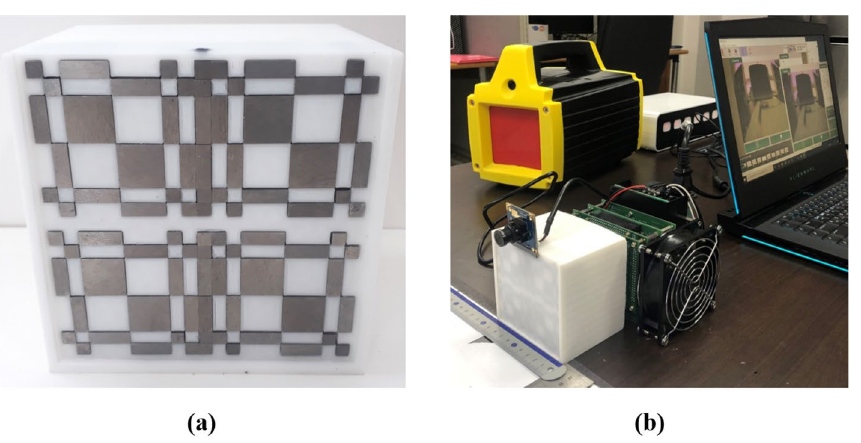
Figure 15. MURA mask ( a ), and developed hand-held DPI equipped with the MURA mask ( b